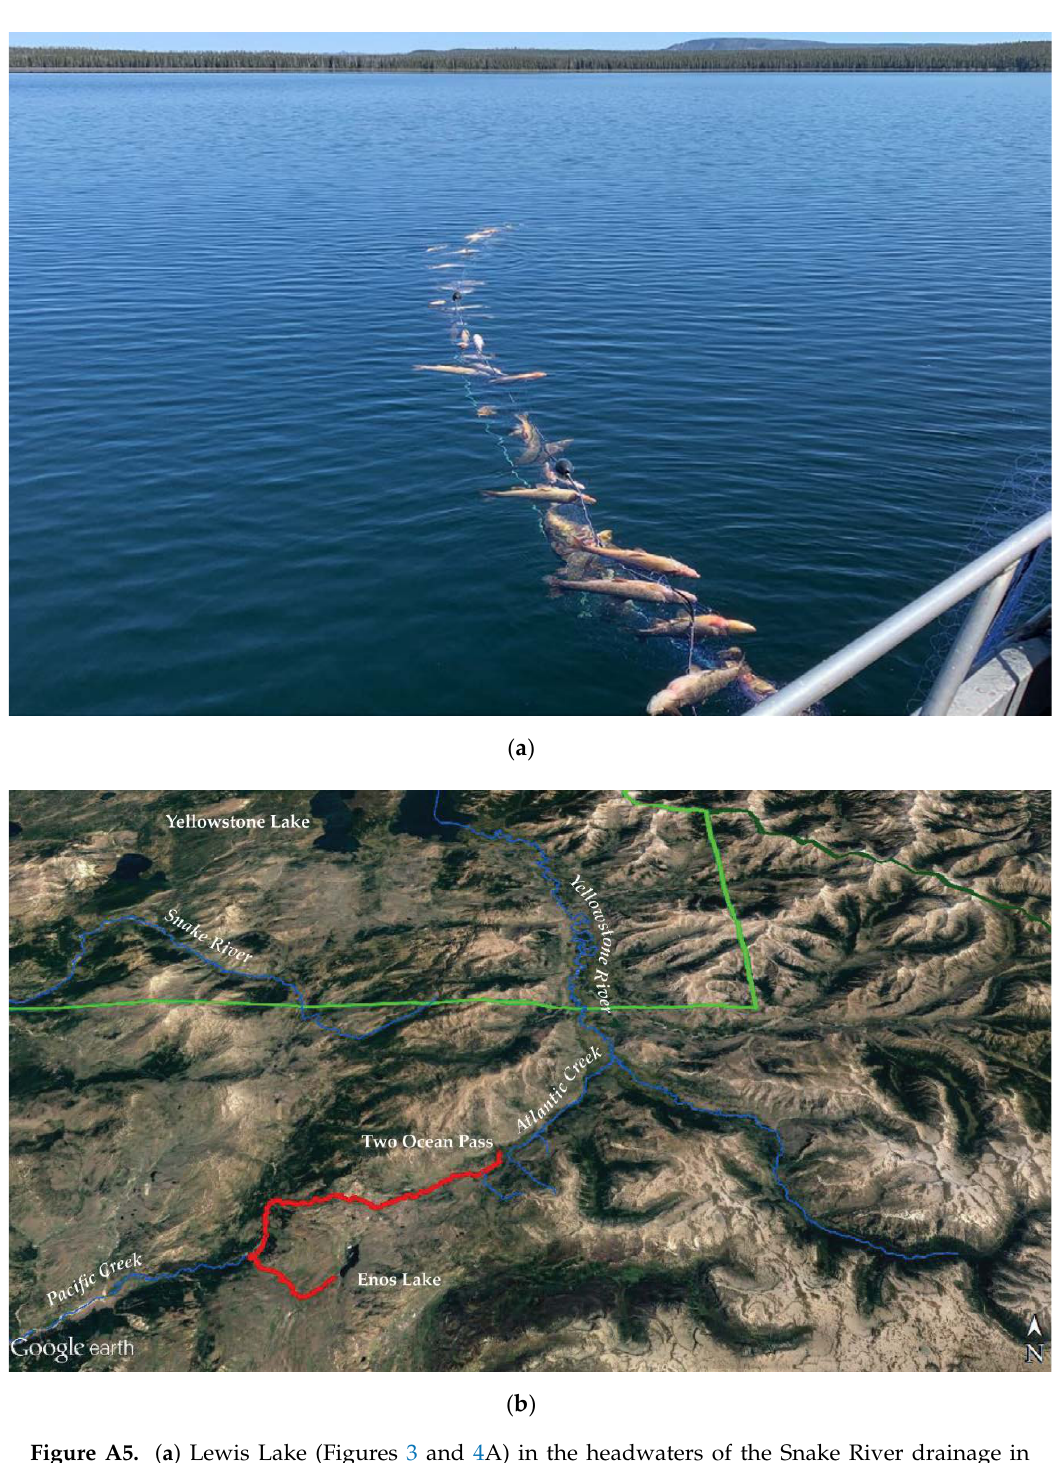
Figure A5. ( a ) Lewis Lake (Figure 3 and Figure 4A) in the headwaters of the Snake River drainage in Yellowstone National Park was isolated by impassable waterfalls and naturally fishless when the park was first established in 1872 [15]. Nonnative lake trout (Lake Michigan, Lawrentian Great Lakes origin) and exotic brown trout (Loch Leven Scotland origin) were among the first nonnative fish stocked to the park when they were introduced to Lewis Lake by the U.S. Commission on Fish and Fisheries in 1890 [110]. The popular sport fishery resulted in Utah chub being introduced to the lake by the 1950s, likely as baitfish. Utah chub became the most abundant fish in Lewis Lake, as corroborated by this gillnet catch in August 2019. ( b ) Utah chub are abundant in Enos Lake within the Pacific Creek watershed, a stream distance of 26 km (in red) from Two Ocean